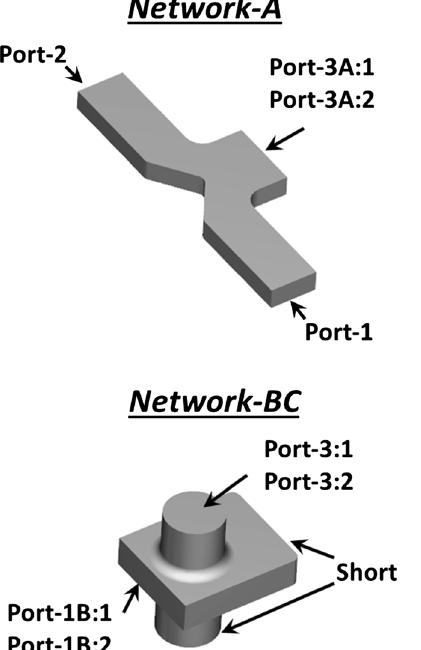
FIG. 6. Subnetworks A and BC used for the second cascade of the polarizer model with labeled port